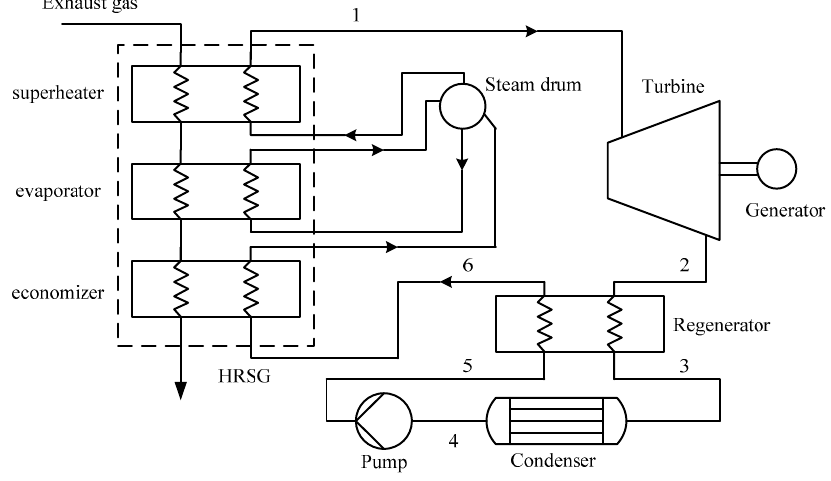
Figure 3. Schematic diagram of the regenerative ORC system for waste heat recovery.